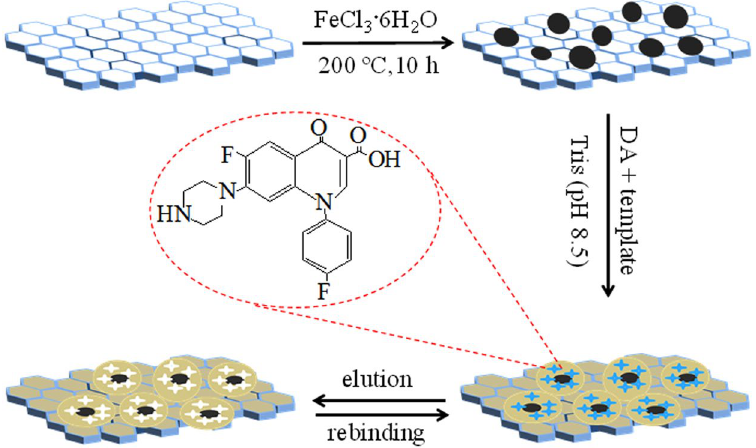
Figure 1. Schematic diagram for the preparation of the PDA@GO/Fe 3 O 4